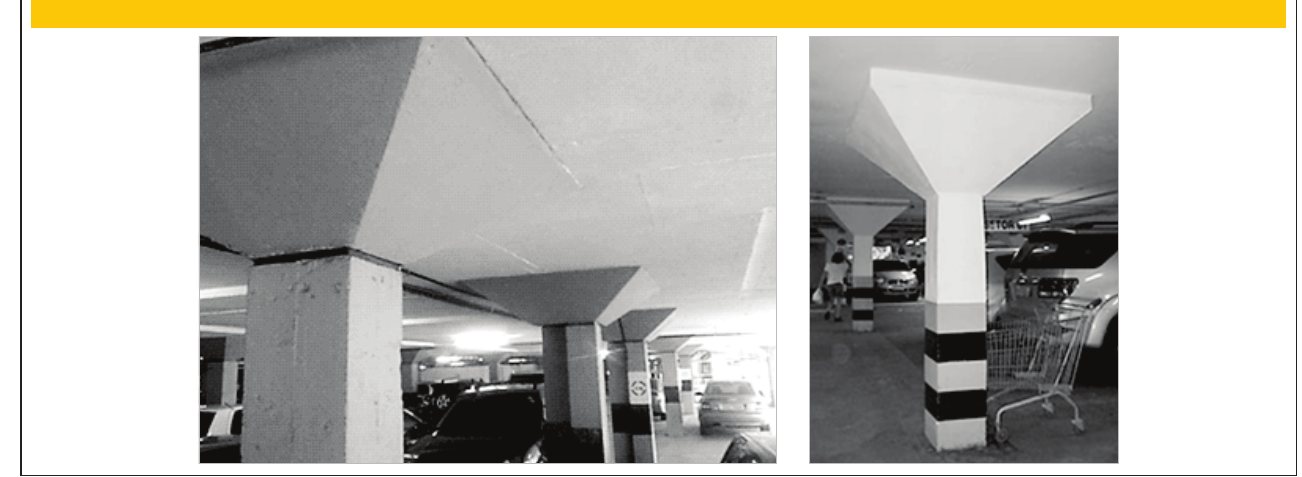
Figure 2 – Mushroom slab with a combination of drop panel and capital in a garage building in